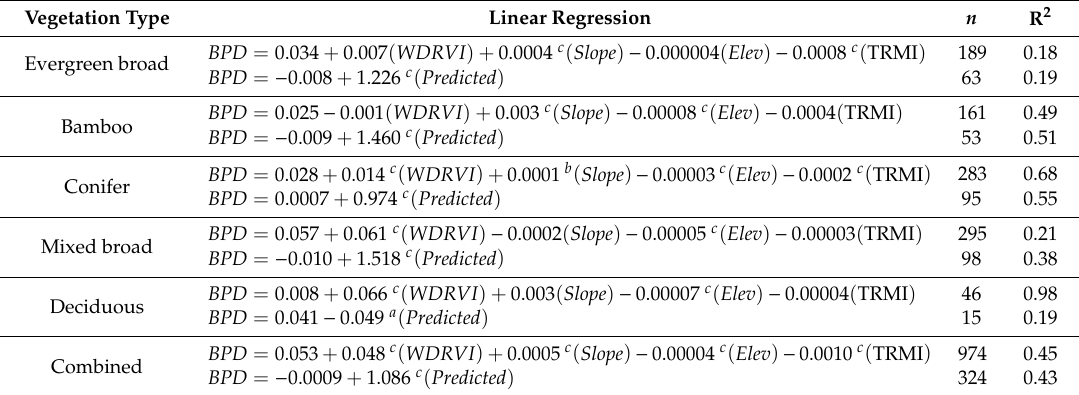
Table 1. OLS regression models for interpolated boar population density in